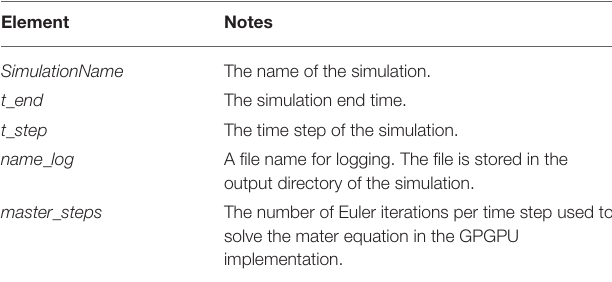
TABLE 5 | The required sub-elements for the SimulationRunParameter section of the XML simulation file.